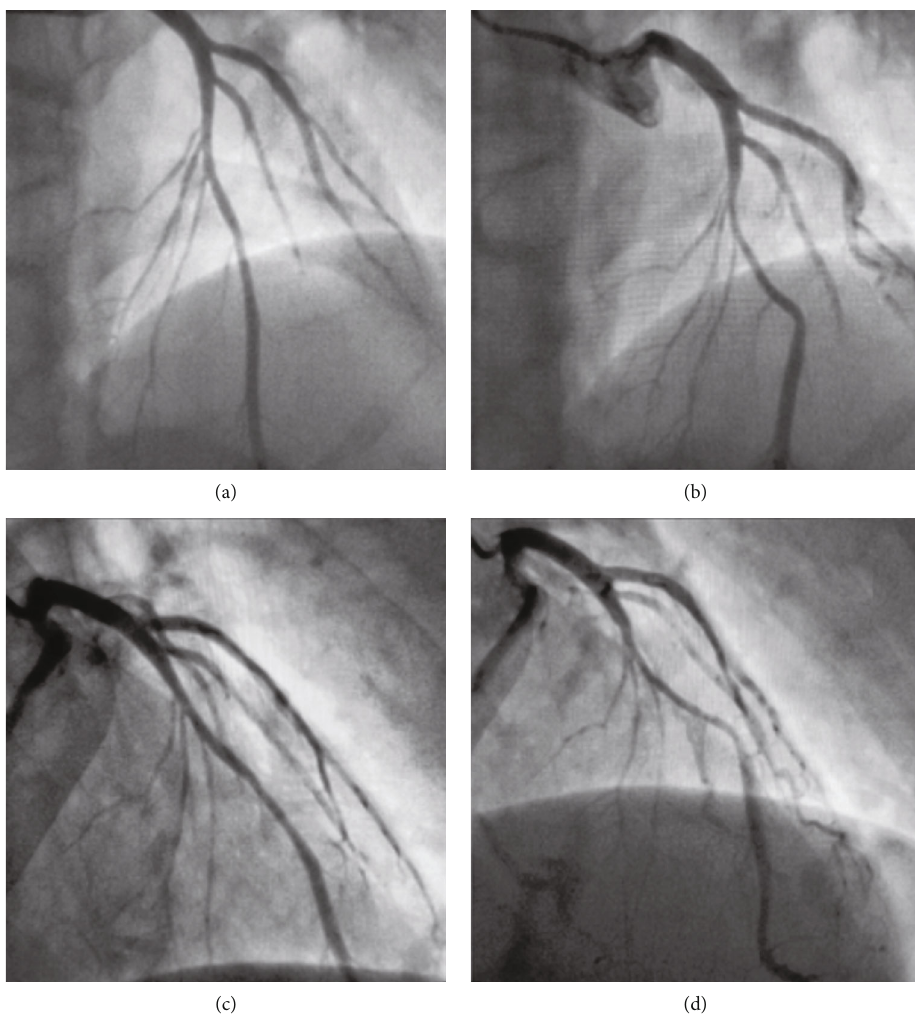
Figure 2: Angiographic images taken on admission to our tertiary centre. Panels (a) and (c) demonstrate images of the left anterior descending artery (LAD) in diastole. Panels (b) and (d) demonstrate the same views during systole with compression of the